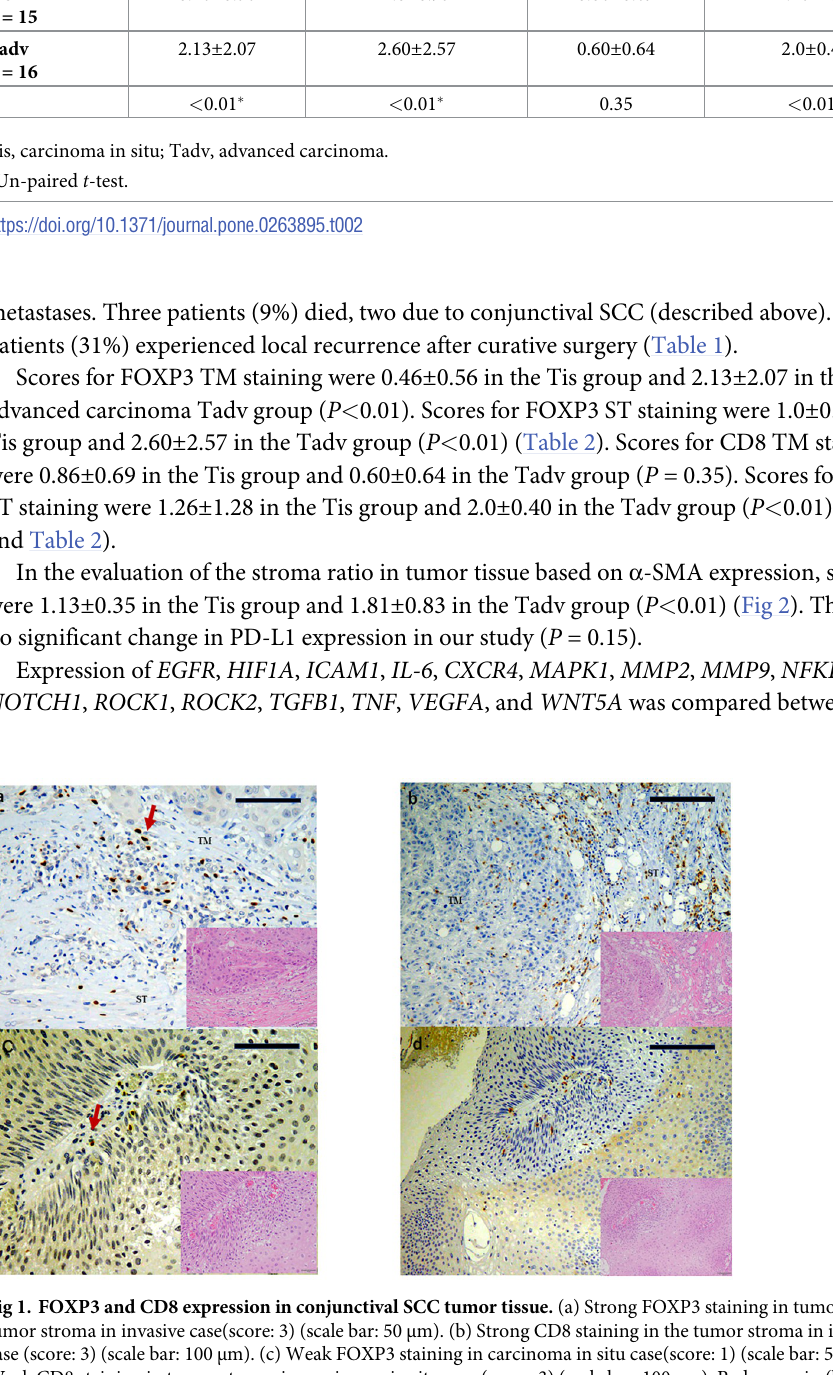
Table 2. FOXP3 and CD8 staining patterns in the tumor and tumor stroma.